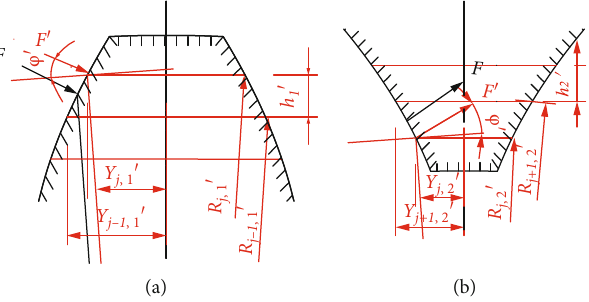
Figure 7: Schematic diagram of the loaded spline considering the transverse vibration: (a) schematic diagram of the loaded external spline considering the transverse vibration; (b) schematic diagram of the loaded internal spline considering the transverse vibration.